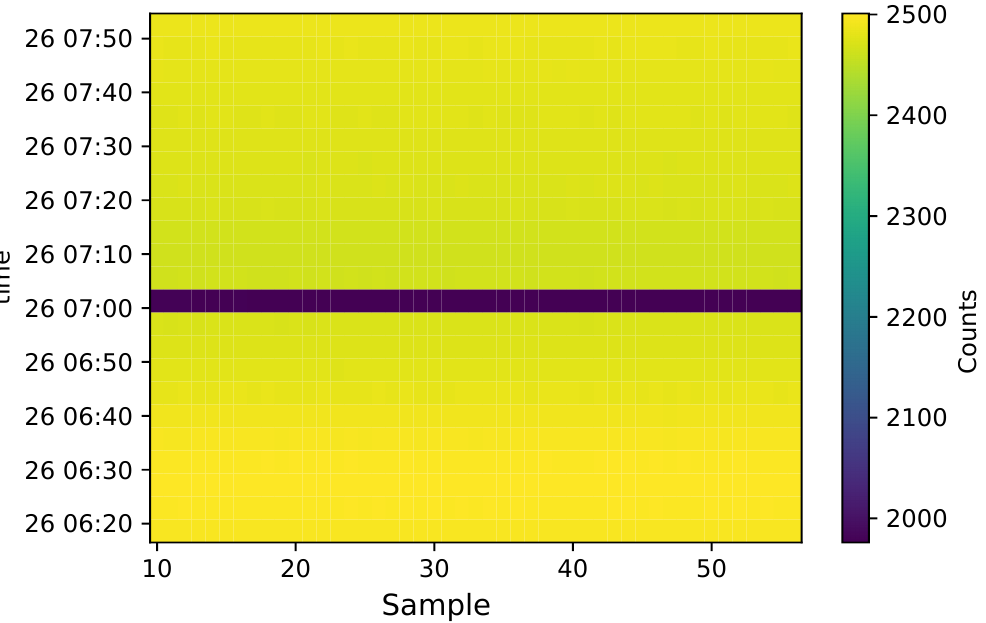
Figure 1. Plot of the numeric counts corresponding to space radiance with HIRS/3 on NOAA-17 during one orbit on 26 September 2002. The first samples were excluded, because the radiometer scanning mirror needs some time to reach its final pointing. The Moon was present in the FoV at 7:01 UTC and provided additional flux. Each scan takes 6.4